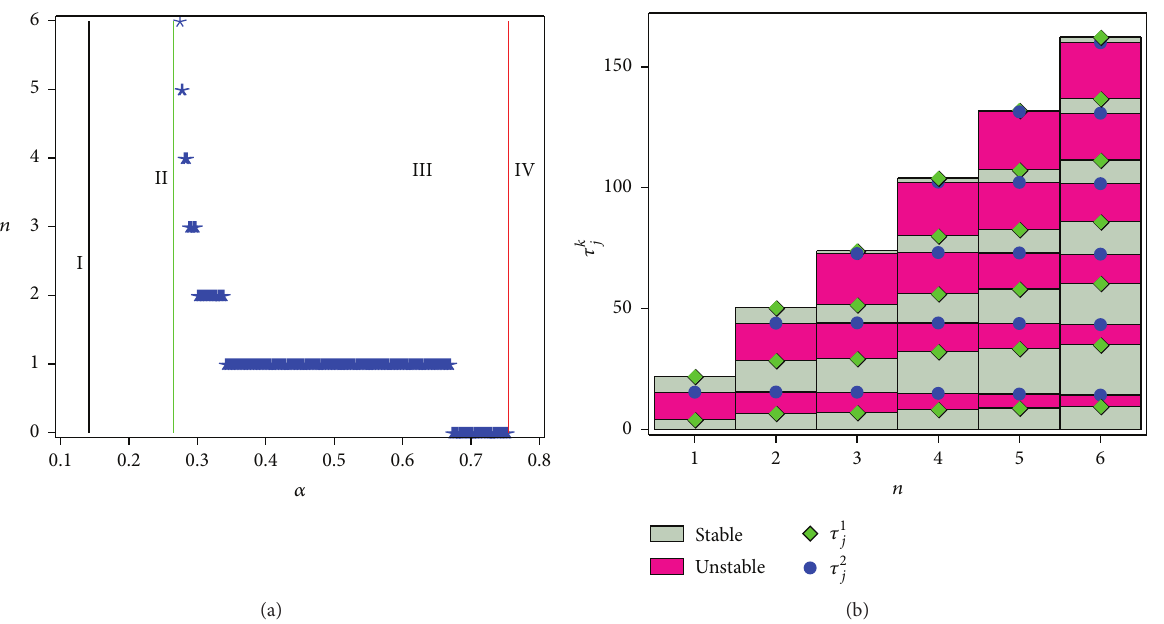
Figure 1: (a) Relationship between the conversion frequency 𝑛 of stability switches for positive equilibrium 𝐸 ∗ and the external source of nutrients 𝛼 ,wherethebluespotsrepresentthevalueof 𝑛 ,theblacklinerepresentstheboundaryoftheexistenceof 𝐸 ∗ ,thegreenlinerepresents the boundary of the appearance of 𝑛 , and the red line represents the disappearance of 𝑛 . (b) Interval values for stability switches and Hopf bifurcation about 𝐸 ∗ , where the green diamonds and the blue dots represent 𝜏 1 𝑗 (0 ≤ 𝑗 ≤ 𝑛) and 𝜏 2 𝑗 (0 ≤ 𝑗 ≤ 𝑛 − 1) , respectively, and the honeydew and deep pink rectangles, respectively, represent the stable and unstable interval of 𝐸 ∗